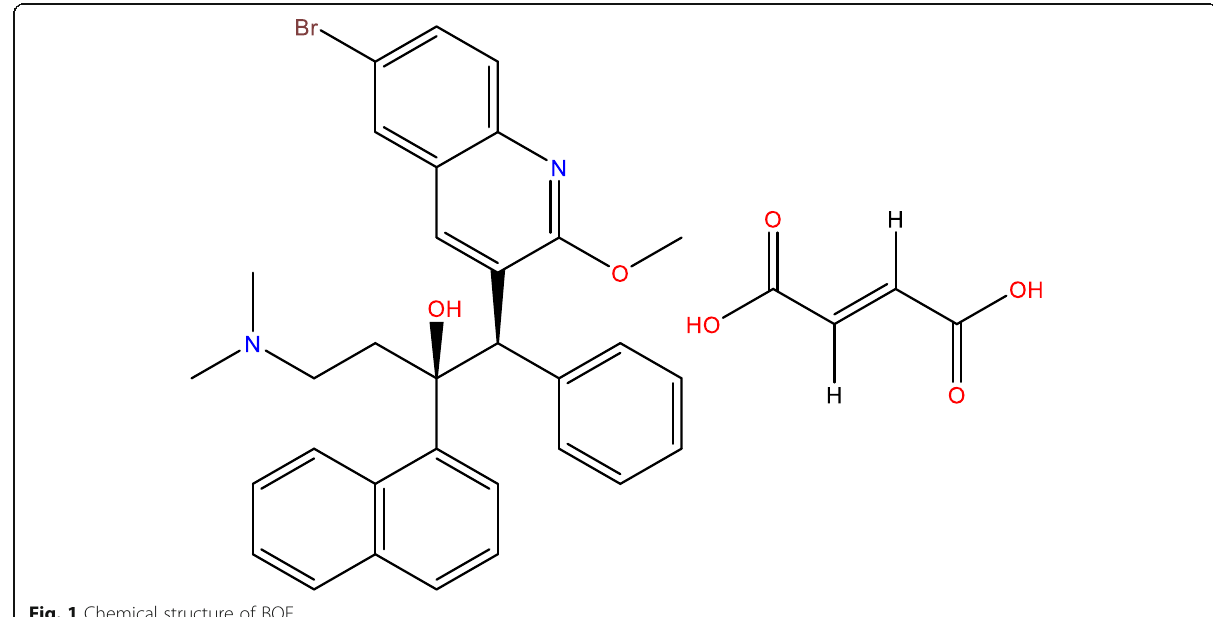
Fig. 1 Chemical structure of